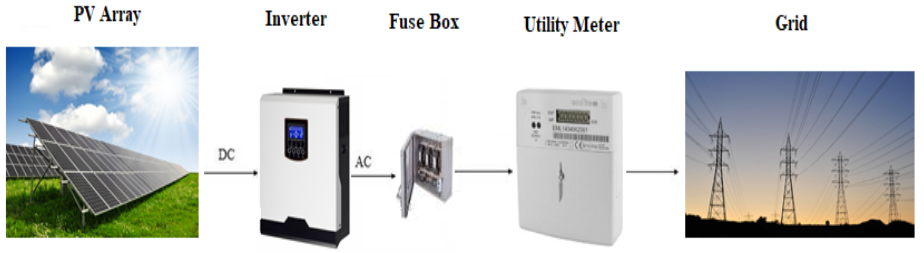
Figure 2. General schematic of the proposed model.